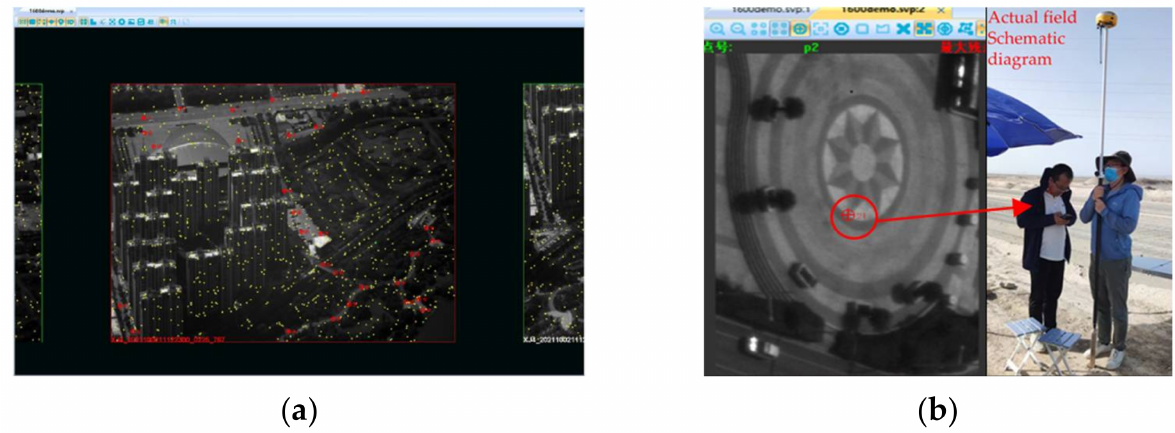
Figure 15. The experiment results of the flight experiment: ( a ) the distribution of the tie points and measuring points; ( b ) the comparison of the experiment